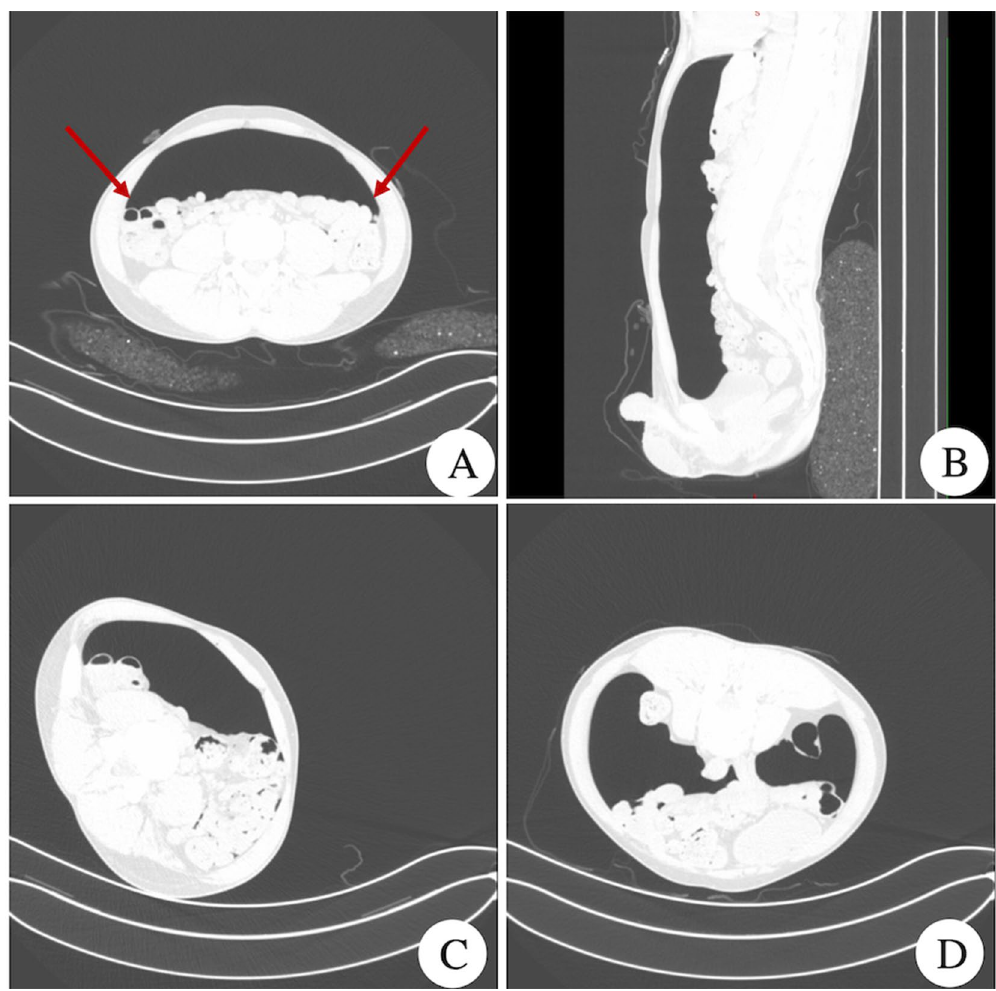
Figure 1. Normal pneumoperitoneal space. ( A ) Shows a normal horizontal axial artificial pneumoperitoneal image (lung window). The peritoneum of the visceral wall is separated, and there is a half-moon-shaped pneumoperitoneal space. The arrows show that the paracolic sulci on both sides are clear and sharp. ( B ) Shows a normal sagittal image of artificial pneumoperitoneum. The pneumoperitoneal space has the shape of a long knife, and the peritoneum of the visceral wall is clearly separated. ( C ) Shows the image of a normal oblique artificial pneumoperitoneum, the abdominal organs are tilted to one side, the contralateral pneumoperitoneum is clear, and the abdominal organs and lateral abdominal wall are clearly displayed. ( D ) Shows the image of the artificial pneumoperitoneum in the normal prone position. Gas fills the space between the posterior abdominal wall and the visceral peritoneum. The relationship between the abdominal organs and the posterior abdominal wall is clearly